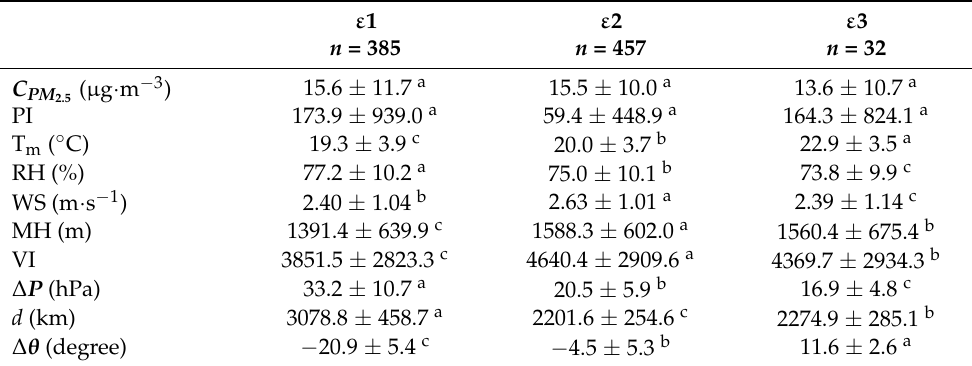
Table 2. Mean PM 2.5 concentrations ( C PM 2.5 ) and major parameters in the Taipei metropolis during winters from 2015 to 2020, when the centres of continental high-pressure system (CHPS) were in sub-regions ε1, ε2, and ε3 .